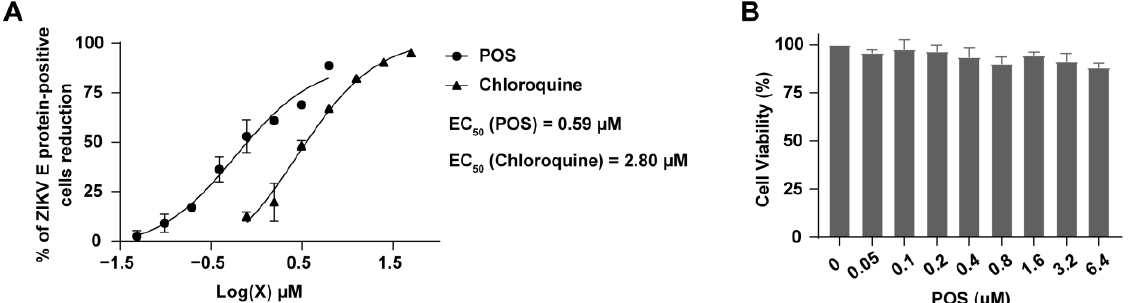
Figure 5. The anti-ZIKV activity of POS. ( A ) Anti-ZIKV activity detected by FACS. Huh-7 cells were infected by ZIKV (SMGC-1) and incubated for 48 h with POS (0.05–6.25 µ M) or chloroquine (0.78–50 µ M). Cells were stained with FITC-anti-ZIKV E protein antibody and analyzed by FACS. Results are expressed as the percentage reduction in the number of ZIKV-infected cells after being treated with compounds. The EC 50 s were calculated as the reduction ratio of ZIKV E protein-positive cells over the concentration of POS. The EC 50 s of POS and chloroquine were 0.59 µ M and 2.80 µ M, respectively. ( B ) The cytotoxicity of POS evaluated by WST-8 assay. The viability of Huh-7 cells were examined at 24 h after the addition of POS at the indicated concentrations (0–6.4 µ